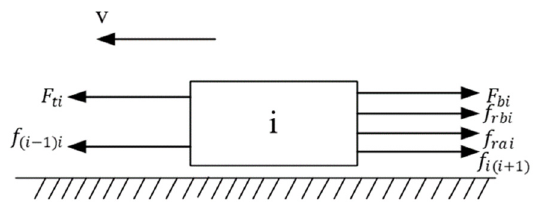
Figure 3. Force diagram of a single maglev train carriage.